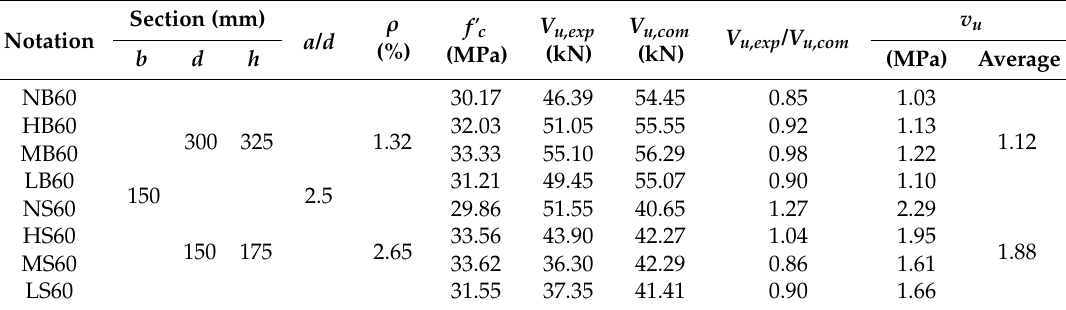
Table 6. Experimental results of the shear strength of the RC beams using a natural and recycled aggregate concrete, without web